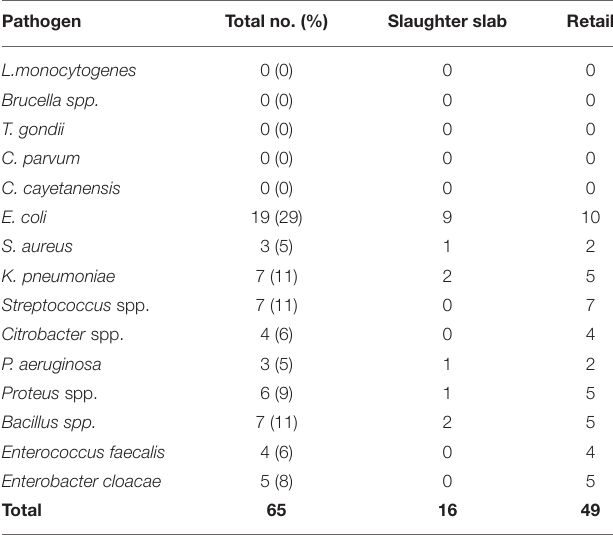
TABLE 6 | Frequency and percentage of pathogens and other bacterial species from 80 raw beef samples obtained from slaughter slabs and retail shops.